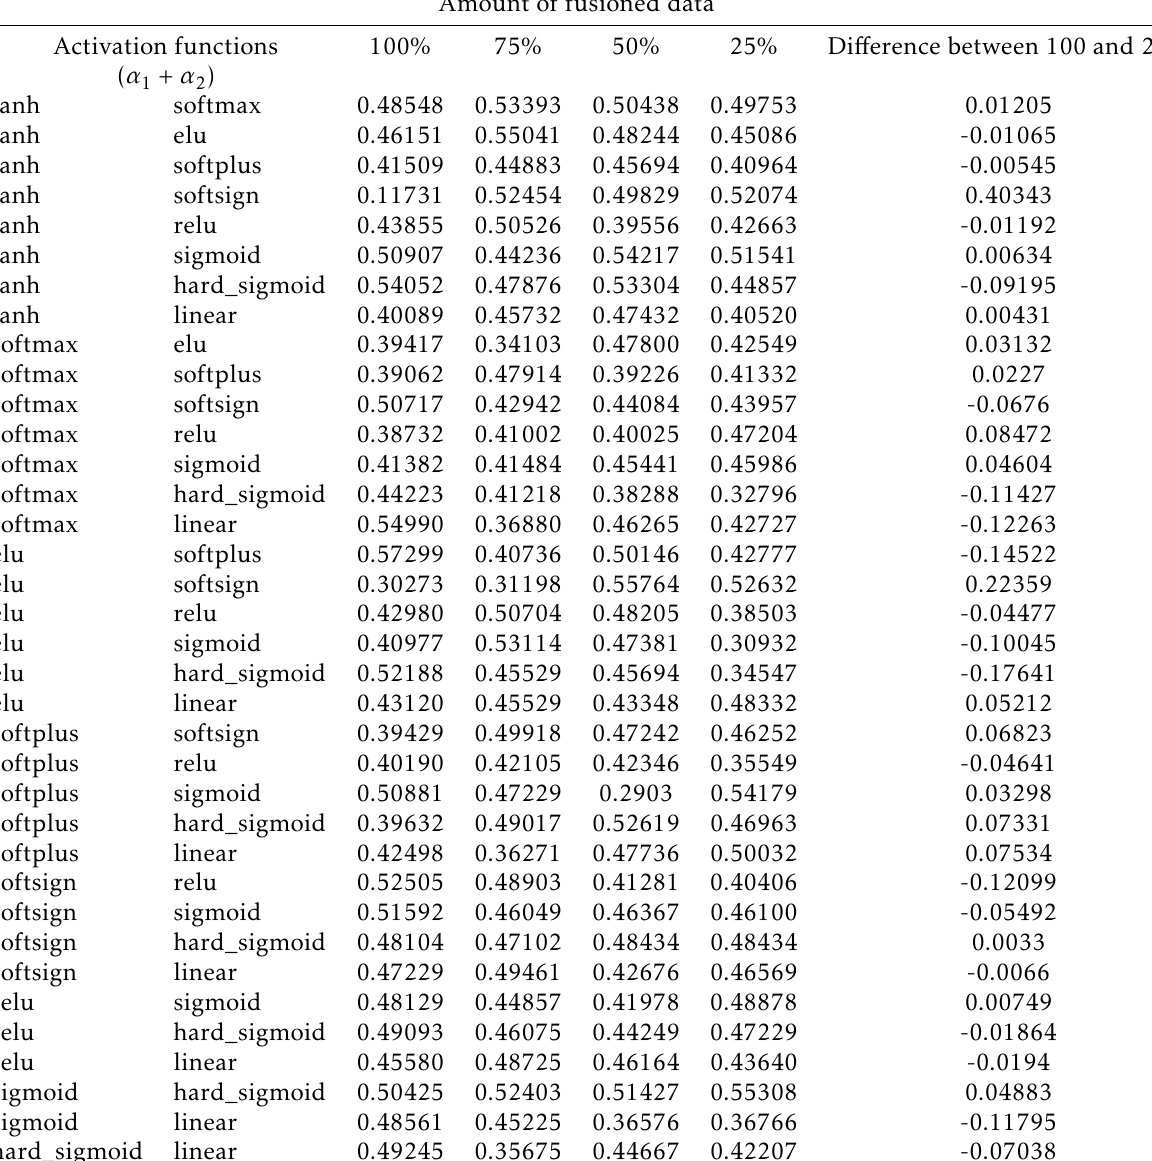
Table 3. Full results of the tuples for the activity recognition models for Subject 3. Complementary information of Table 4.